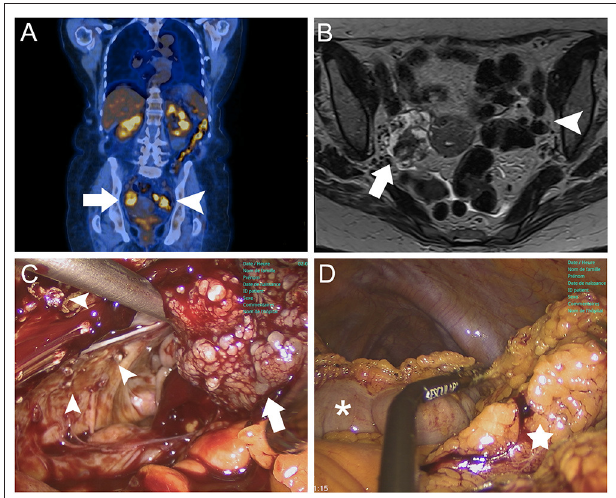
FIGURE 1 | Case 1 images. (A) Coronal PET/CT scan demonstrating metabolically active lesions on right (white arrow) and left ovaries (white arrowhead). (B) Axial gadolinium-enhanced T1-weighted MRI showing bilateral adnexal masses with heterogeneous solid appearance, irregular contours, and measuring 4.1 × 2.9 × 4.2cm on the right (white arrow) and 3.1 × 1.4 × 1.0cm on the left side (white arrowhead). (C) vNOTES approach showing a slightly enlarged right ovary with external vegetations (white arrow) and multiple peritoneal implants on the right pelvic sidewall (white arrowheads). (D) vNOTES infracolic omentectomy with separation of the greater omentum (white star) from the transverse colon (white asterisk) using a 5-mm Caiman ®